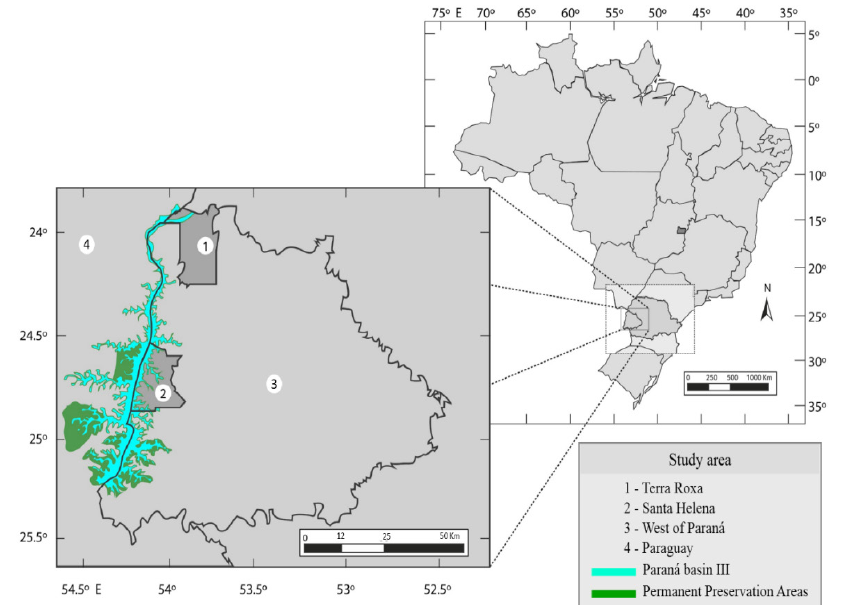
Fig 1. Location map showing the study area. (right) map showing the position of Paraná State in Brazil, (Left) map showing the sampling counties in the region west of Paraná State, as well as the Paraná River Basin III, which borders